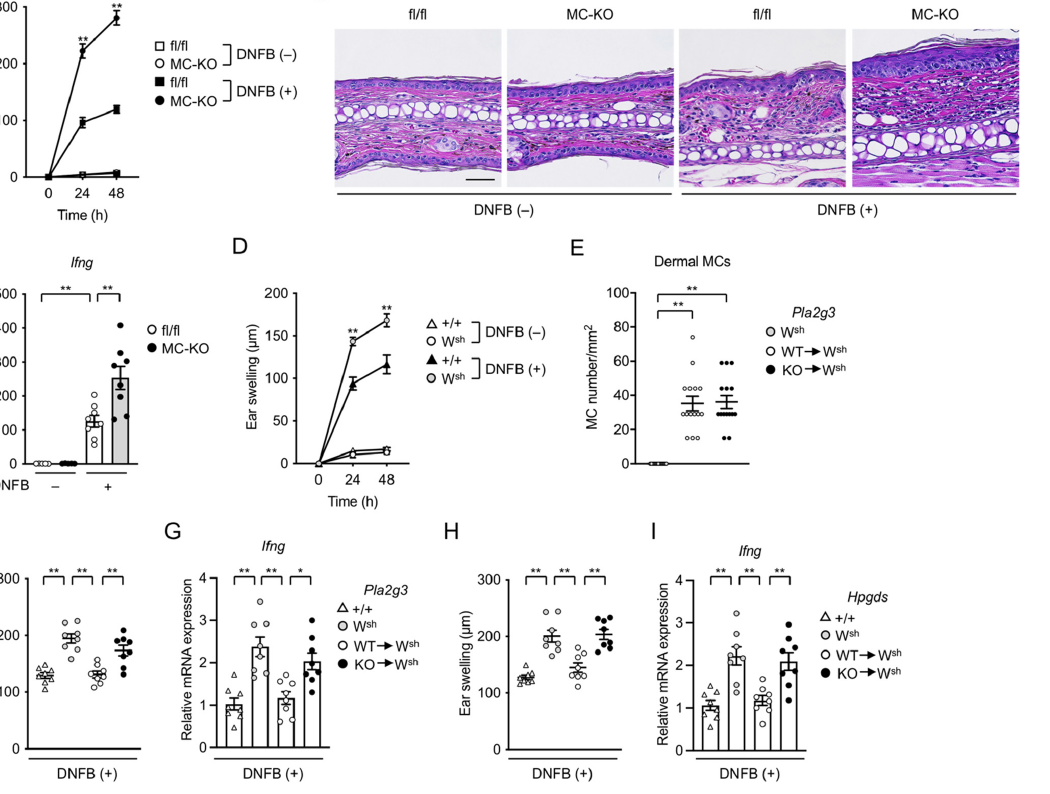
Figure 4. Exacerbated hapten-induced CHS by deficiency of Pla2g3 or Hpgds in MCs. ( A ) Changes in ear thickness over time after second challenge with vehicle ( − , n = 5) or DNFB (+, n = 8) in Pla2g3 fl/fl (fl/fl, squares) and Pla2g3 fl/fl Mcpt5 - Cre (MC-KO, circles) mice. ( B ) Representative photomicrographs of sections of ear pinnae in Pla2g3 fl/fl and Pla2g3 fl/fl Mcpt5 - Cre mice sacrificed at 48 h with (+) or without ( − ) the second DNFB challenge. Scale bar, 25 µm. ( C ) Expression of Ifng in ear skin of vehicle (n = 5) or DNFB (n = 8)-treated Pla2g3 fl/fl and Pla2g3 fl/fl Mcpt5 - Cre mice. Gapdh was used as a reference gene for normalization. Expression level in fl/fl without DNFB treatment was regarded as 1. ( D ) Ear swelling in response to vehicle (n = 5) or DNFB (n = 8) in sensitized Kit W-sh (W sh , circles) and Kit +/+ (+/+, triangles) mice. ( E ) The number of dermal MCs/mm 2 in ear pinnae of Kit W-sh mice that had been reconstituted locally with Pla2g3 +/+ (WT → W sh ) or Pla2g3 − / − (KO → W sh ) BMMCs. Thirty views for each group (n = 5). ( F – I ) Ear swelling ( F,H ) and Ifng expression ( G , I ) in response to the second DNFB challenge in ear skin of Kit +/+ (+/+) and Kit W-sh mice that had been reconstituted with or without Pla2g3 WT and Pla2g3 KO BMMCs ( F , G ) or Hpgds WT and Hpgds KO BMMCs ( H , I ) (n = 8). In ( G , H ), expression level of Ifng (normalized to Gapdh ) in +/+ was regarded as 1. Data, mean ± SEM; *, p < 0.05; **, p < 0.01; two-way ( A , D ) and one-way ( E – I ) ANOVA. Data are pooled from 2 independent experiments performed, each of which gave similar results.